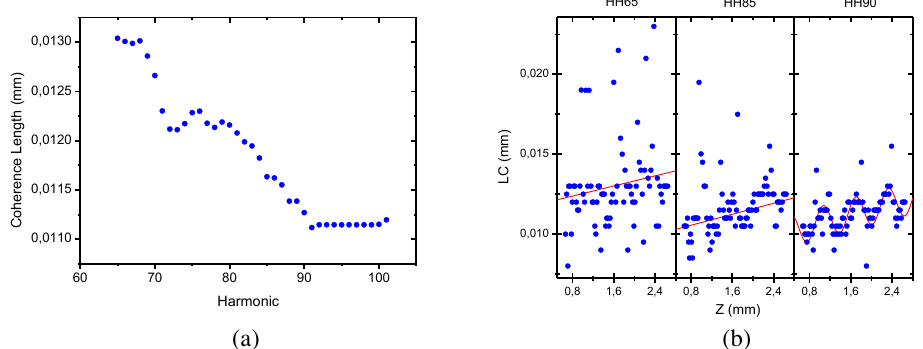
Fig. 2. (a) Averaged coherence length for a propagation of z=2 mm. (b) Coherence length for some harmonics along propagation together with different fits (red lines).